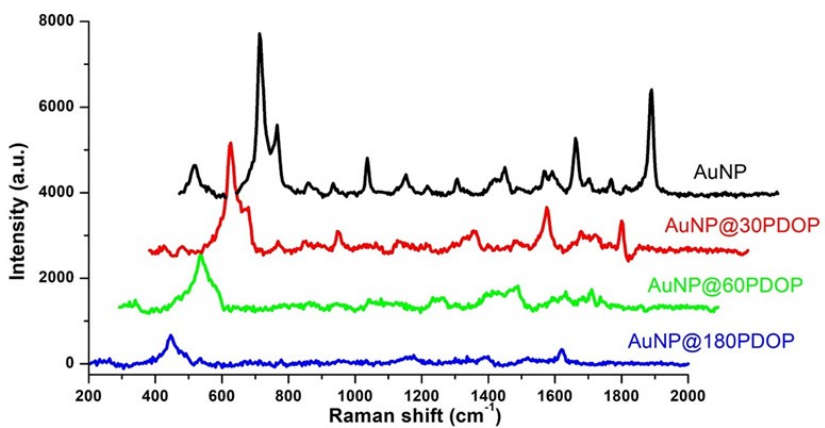
Figure 9. Representative Raman measurements of AuNP and AuNP@PDOP for different PDOP deposition times (numbers indicate deposition times in min). The final concentration of methylene blue (MB) for Raman measurement is 10 −5 M.